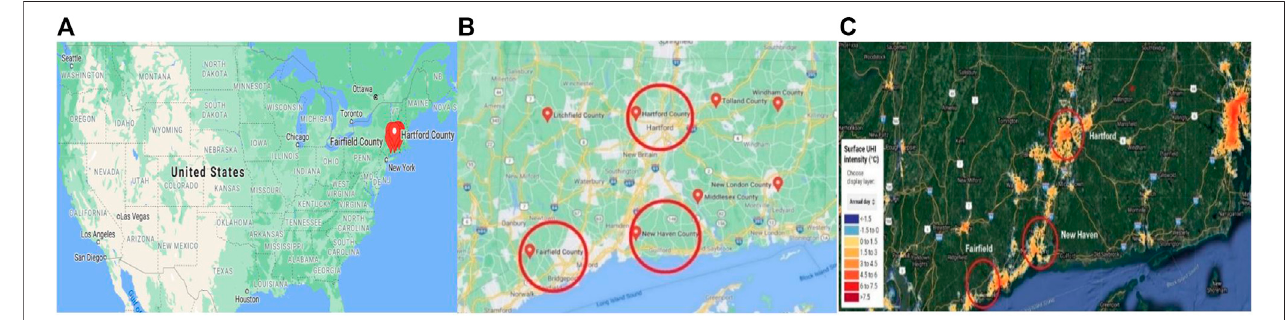
FIGURE2| MapoftheUnitedStatesshowingthelocationsofthecountieswithinthestateofConnecticut (A) ,closemapofthestudyareahighlightingthelocations of the three counties (B) and impacts of urban heat islands ampli fi ed by climate change within the study area (C) .